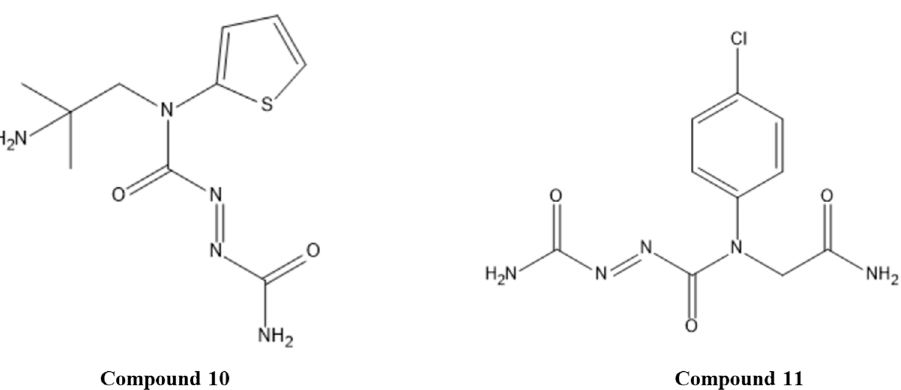
Figure 3. Structures of studied synthetic compounds as E6/E6AP inhibitors acting by ejecting